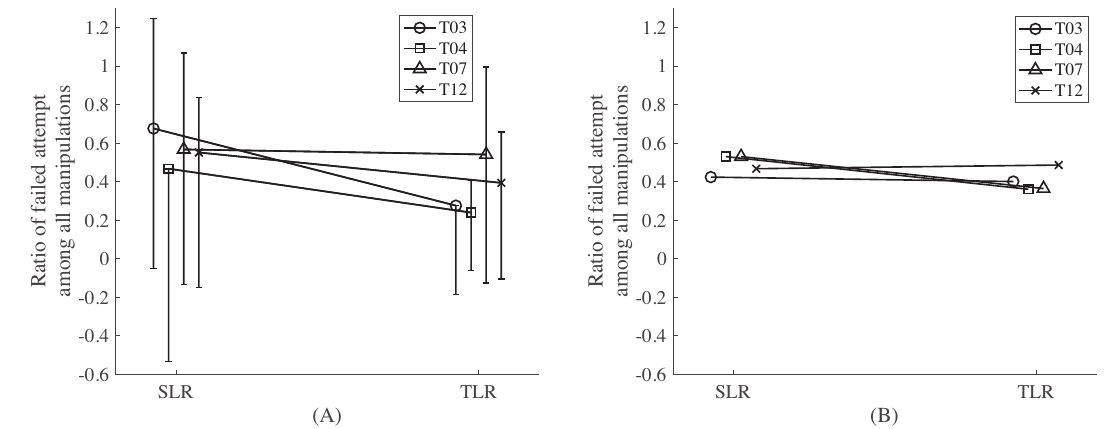
Figure 8. ( A ) Average and range of the failed attempts ratio among all manipulations identified by three coders (C1, C2 and C3), ( B ) Number of events detected by